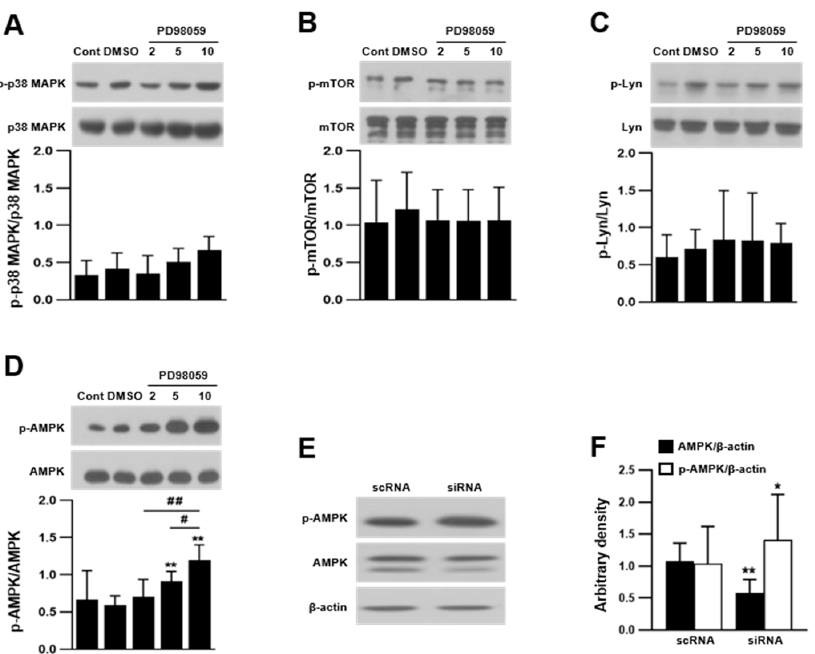
Figure 5. Inhibition of ERK increased adenosine 5 ′ -monophosphate-activated protein kinase (AMPK) phosphorylation. Cell lysates were prepared from PD98059-treated OCs and ERK2 siRNA-transfected OCs, and activation of kinases was measured by Western blotting. Phosphorylation of p38 MAPK (n = 4) ( A ), mTOR (n = 3) ( B ), Lyn (n = 3) ( C ), and AMPK (n = 6) ( D ). ( E , F ) AMPK phosphorylation was determined in OCs of ERK2 siRNA-transfected cells (n = 5). Each result represents the mean ± SD. * p < 0.05 and ** p < 0.01 vs. control or scRNA, and # p < 0.05 and ### p < 0.001.